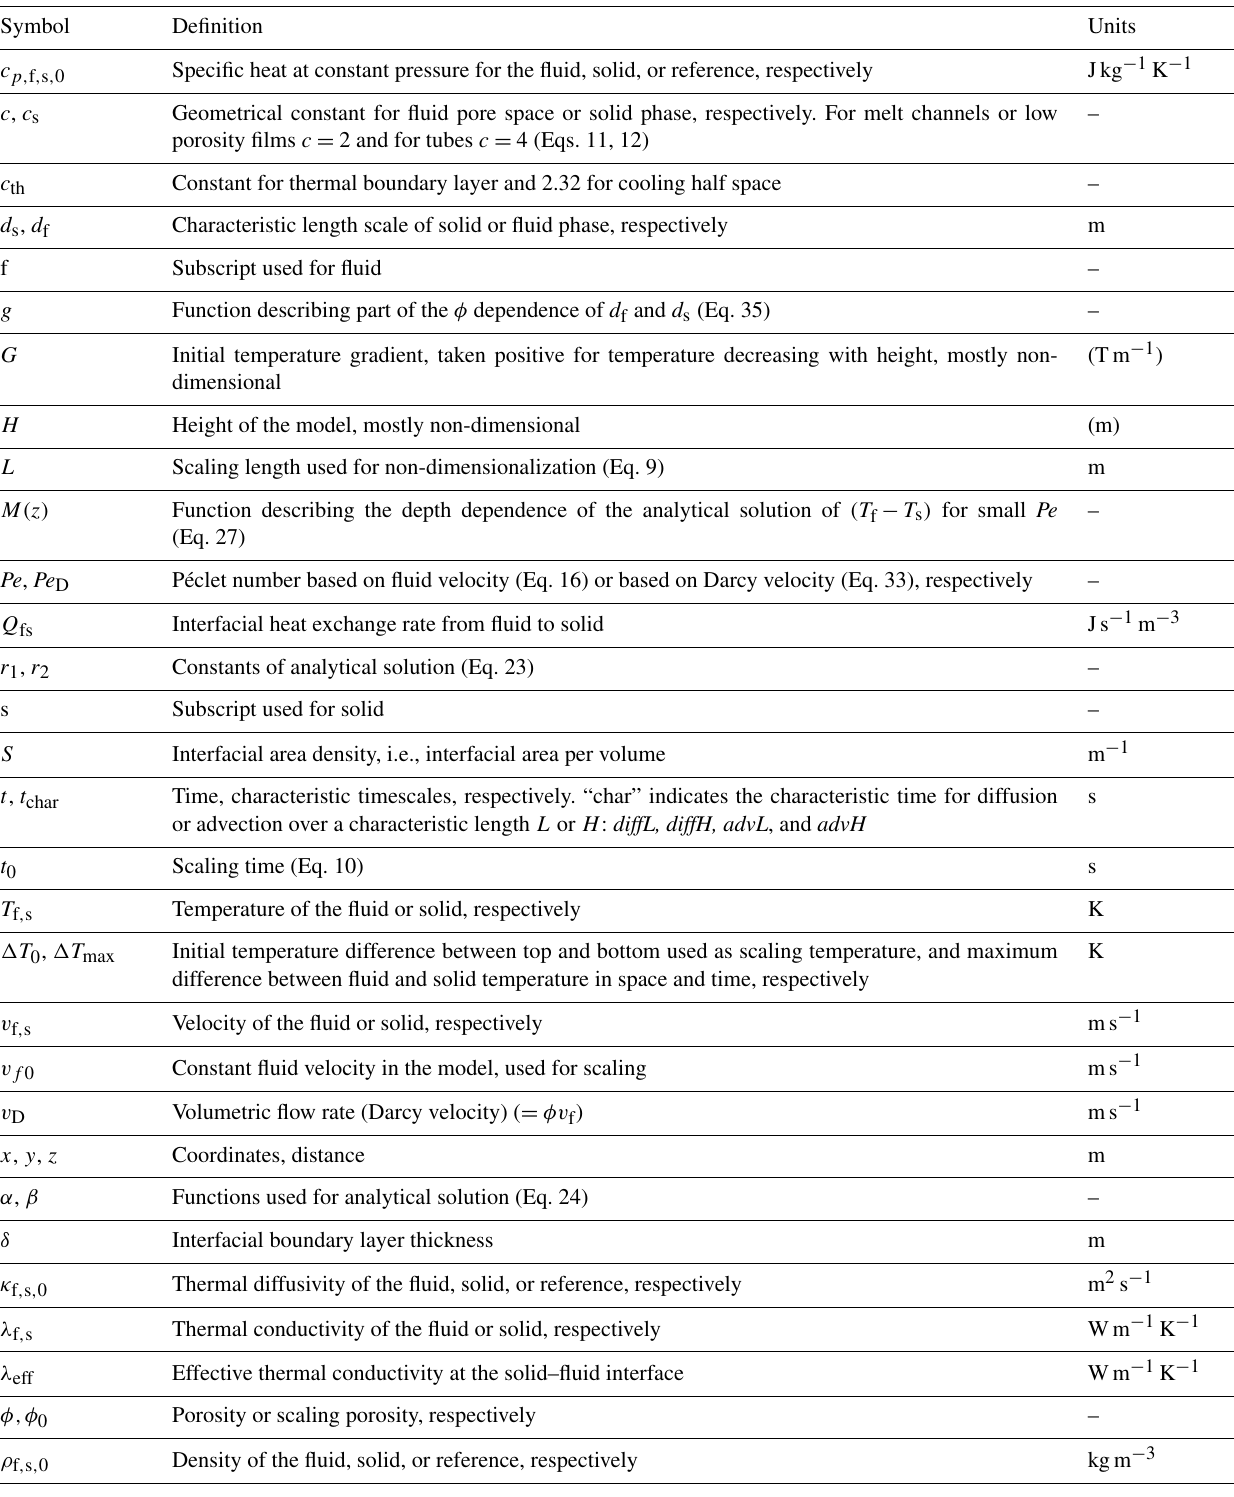
Table 1. Symbols, their definition, and physical units used in this study. Symbol